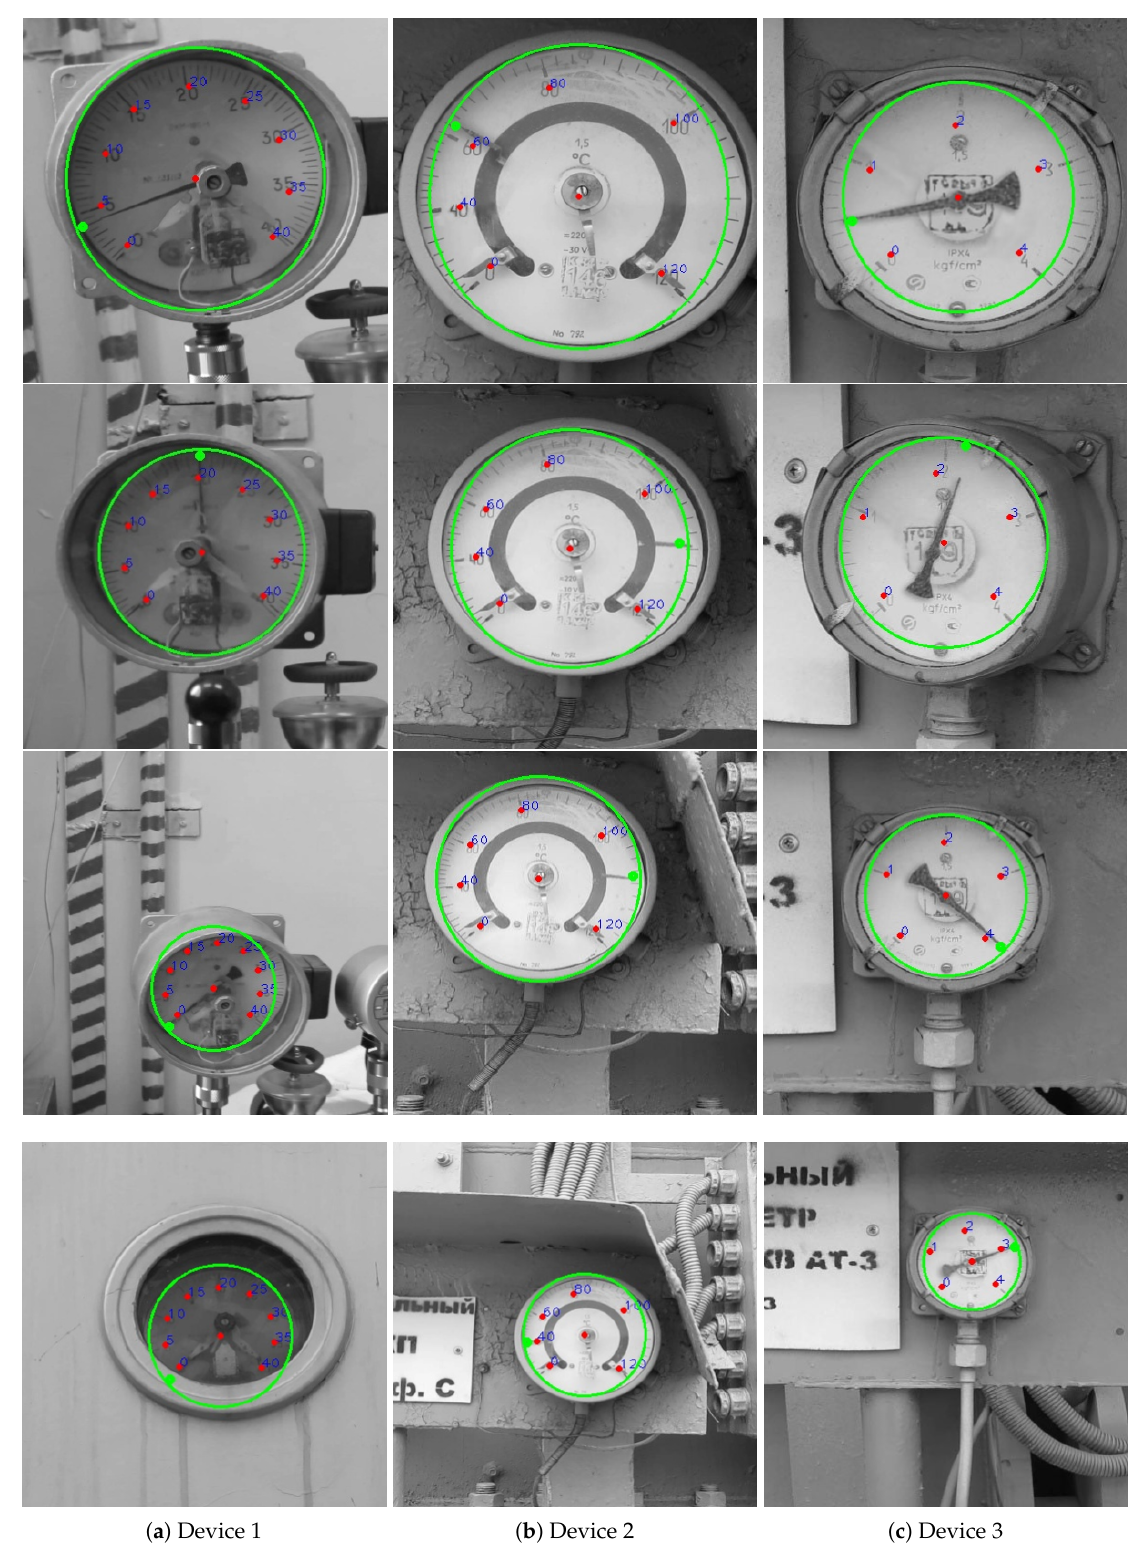
Figure 7. Examples of grid generation for various devices. Detection takes around 3 ms of GPU computations for a {1024 × 512} image. The bottom row demonstrates some of the most difficult